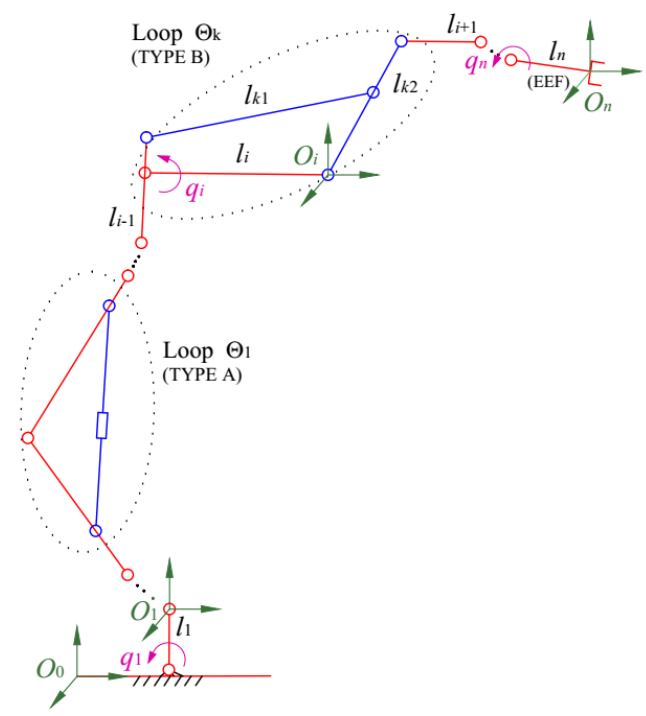
Figure 2. A generalized configuration of the hybrid robots Class III.